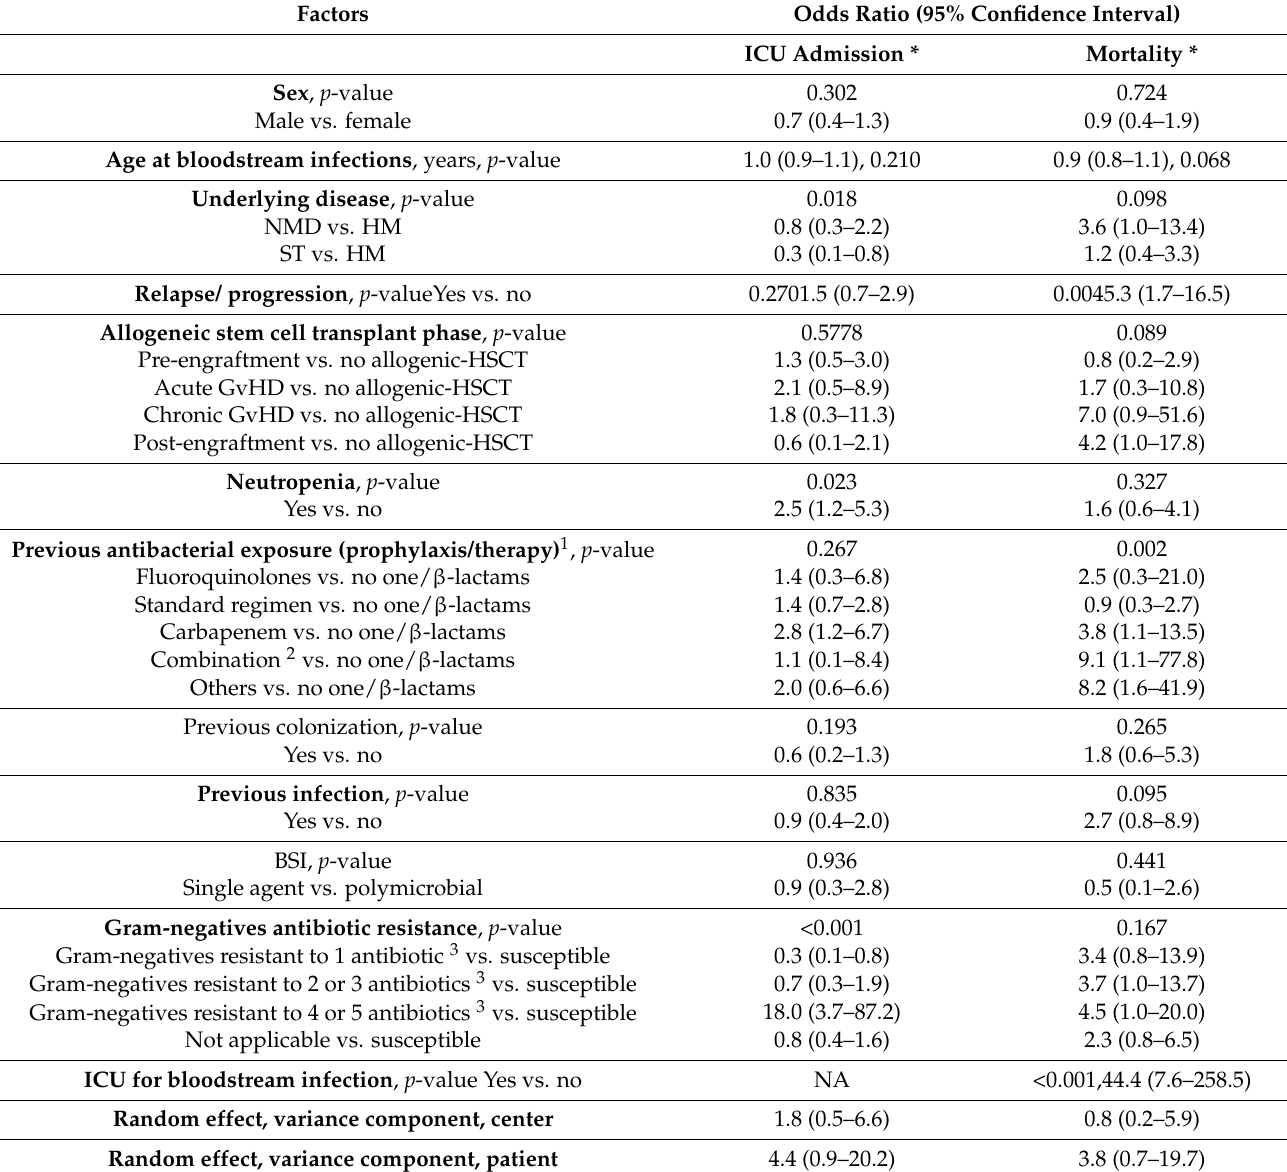
Table 4. Multivariable logistic regression models for ICU admission or mortality during